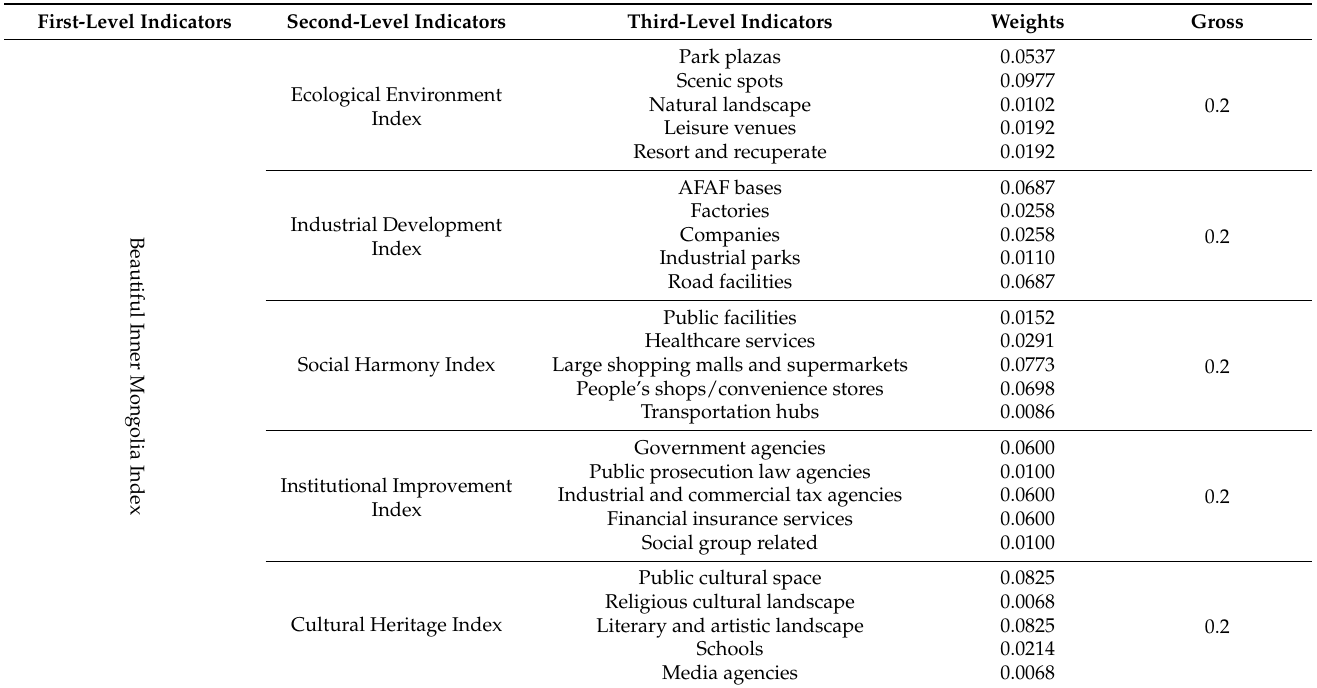
Table 2. Weight list of the Beautiful Inner Mongolia construction evaluation index system. First-Level